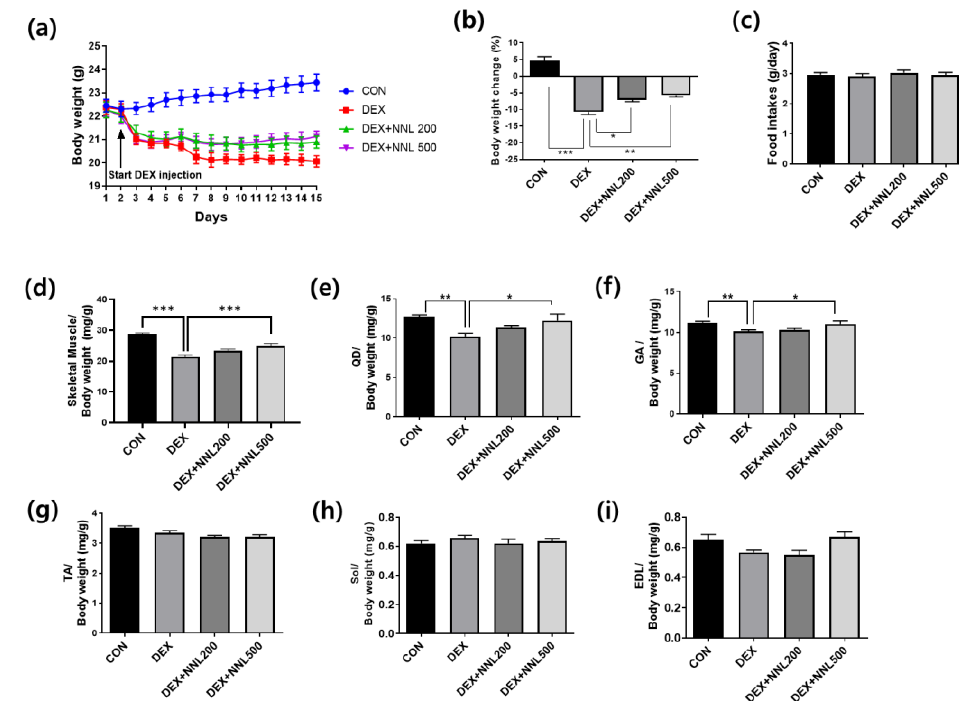
Figure 2. The NNL extract administration increased body and muscle weights in DEX-induced muscle atrophy in mice. The NNL extract (200 or 500 mg/kg/day) was orally administered to C57BL/6 male mice (8 weeks old) once a day for 15 days. Two days after NNL extract administration, DEX (20 mg/kg/day) was intraperitoneally injected once a day for 13 days. ( a ) Changes in body weight during the experimental periods. ( b ) The calculation of body weight changes compared to the body weight in day 0. ( c ) Food intake during the experimental period. ( d ) The measurement of total skeletal muscle weights. ( e ) Quadriceps (QD) muscle weight. ( f ) Gastrocnemius (GA) muscle weight. ( g ) Tibialis anterior (TA) muscle weight. ( h ) Soleus (SOL) muscle weight. ( i ) Extensor digitorum longus (EDL) muscle weight. All data are shown as mean ±S.E.M., n = 11/group; * p < 0.05, ** p < 0.01, *** p < 0.001.